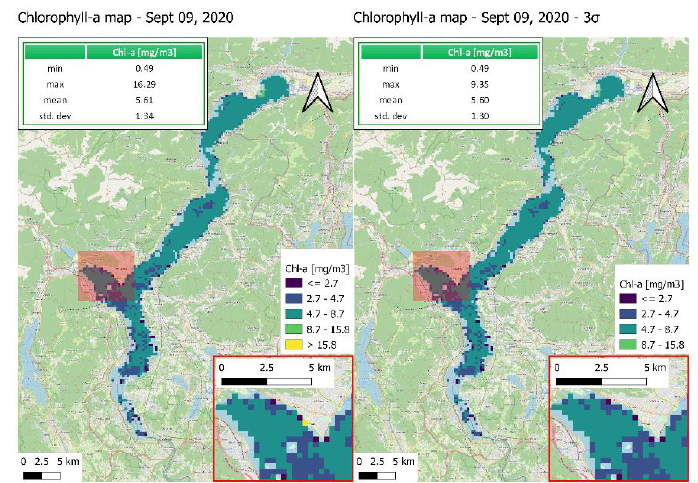
Figure 3. Pre- and Post- (left and right) outlier rejection using the three-sigma